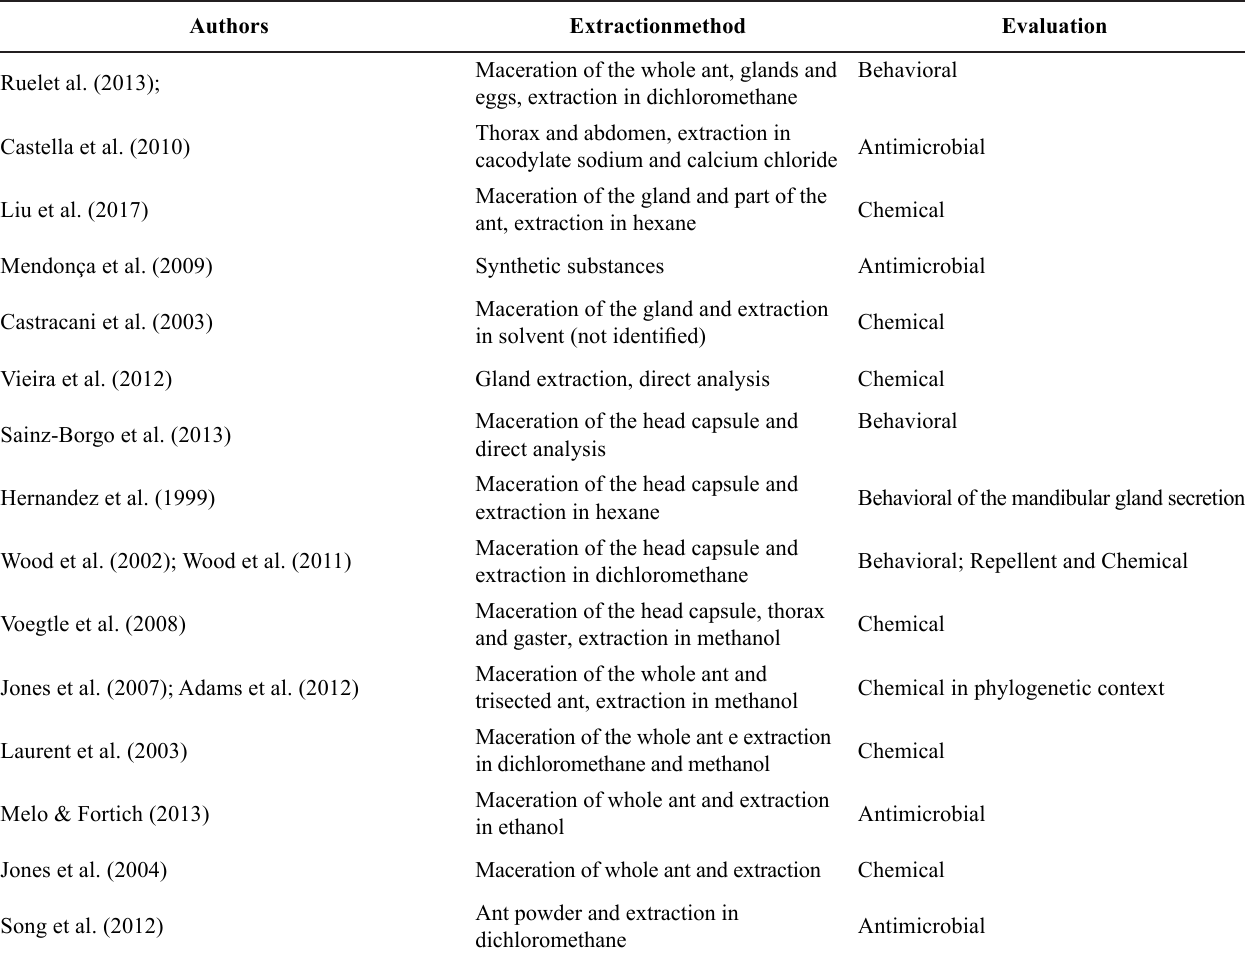
Table 2 . Articles with different methods of extraction and evaluations to test the origin and functions of substances extracted from